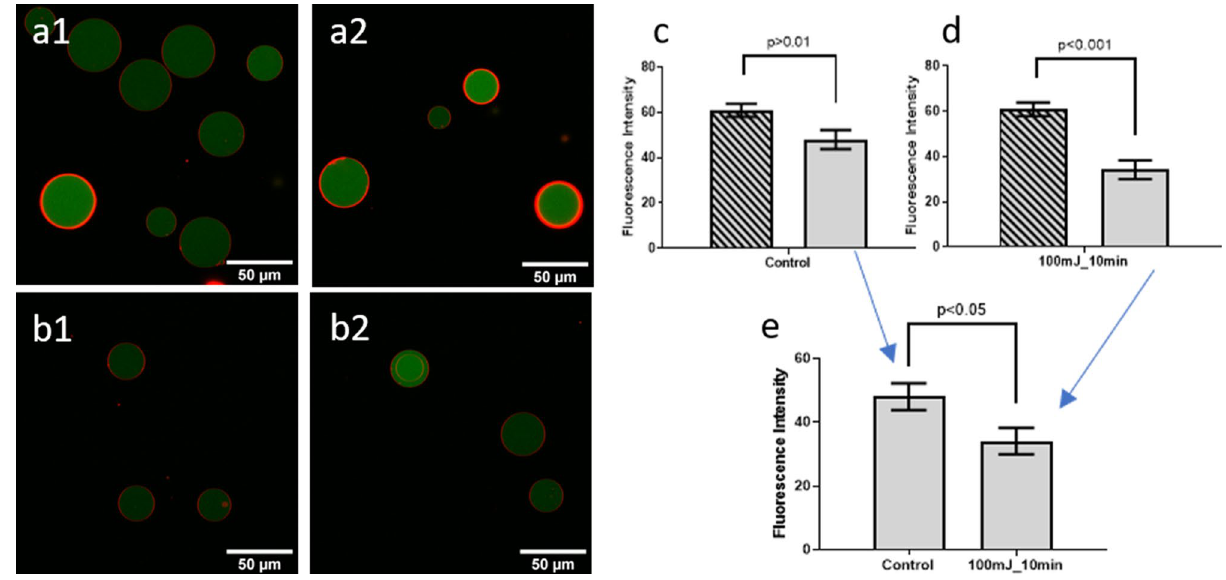
Figure 6. Confocal images of GUVs containing GFP and image analysis. ( a ) Representative examples of images of GUVs before exposure to photoacoustic waves, and ( b ) after exposure to photoacoustic waves generated with laser pulses at 100 mJ/cm 2 for 10 min. ( c ) Control before and after all procedures except exposure to photoacoustic waves, to assess the effect of manipulating GUVs for 2 h. ( d ) Fluorescence before and after exposure to photoacoustic waves. ( e ) Comparison between control GUVs after the procedures of exposure, but without exposure to photoacoustic waves, and GUVs exposed to photoacoustic